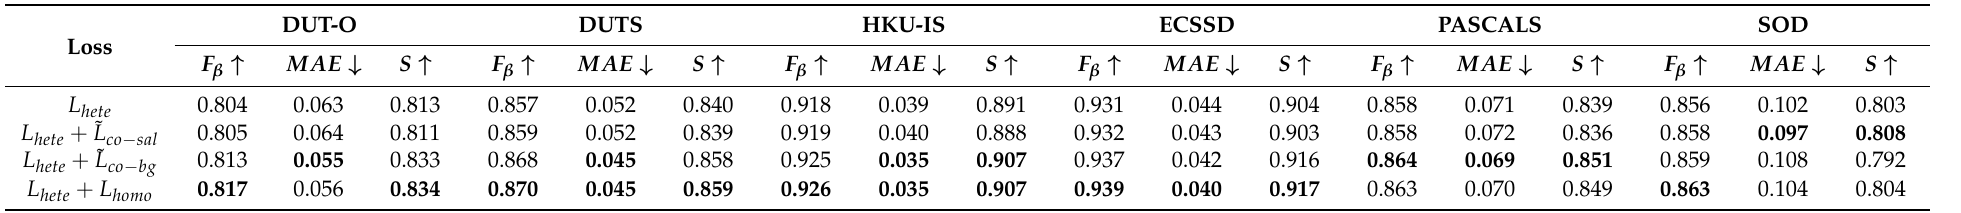
Table 1. Quantitative results of the proposed loss function with different configurations. L hete means only using the heterogeneous ranking loss, L hete + ˜ L co − bg means adopting the heterogeneous ranking loss and the consistency loss of cobackground pairs, L hete + ˜ L co − sal means adopting the heterogeneous ranking loss and the consistency loss of co-saliency pairs, and L hete + L homo indicates utilizing the proposed label-guided ranking loss. The best performance is boldfaced . DUT-O DUTS HKU-IS ECSSD PASCALS SOD Loss F β ↑